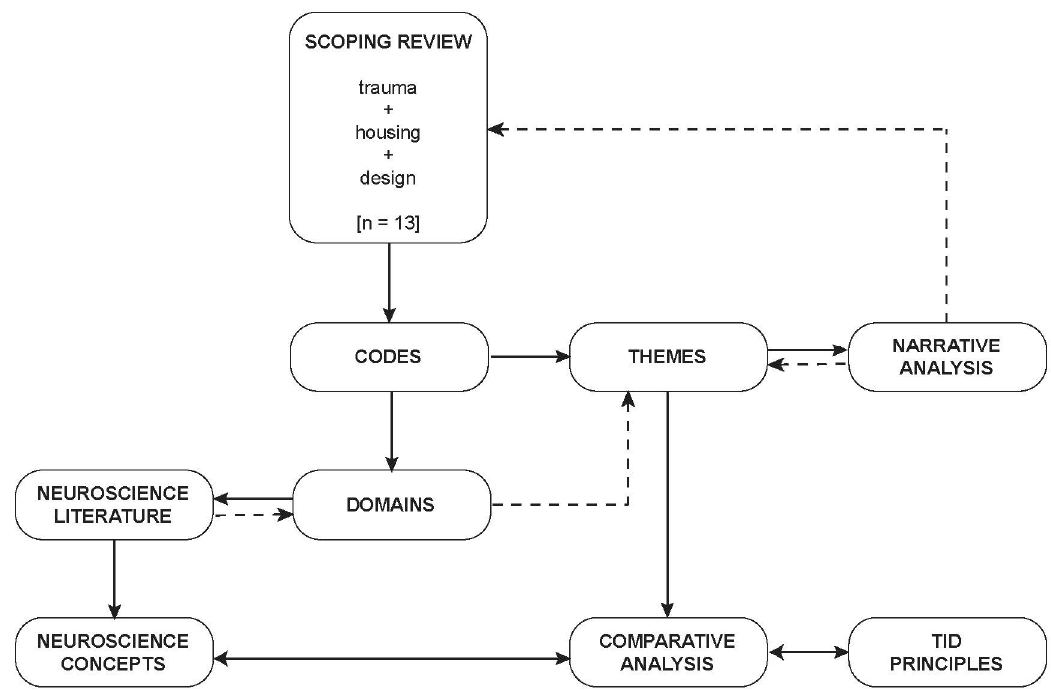
Figure 2. Diagram illustrating analysis process.